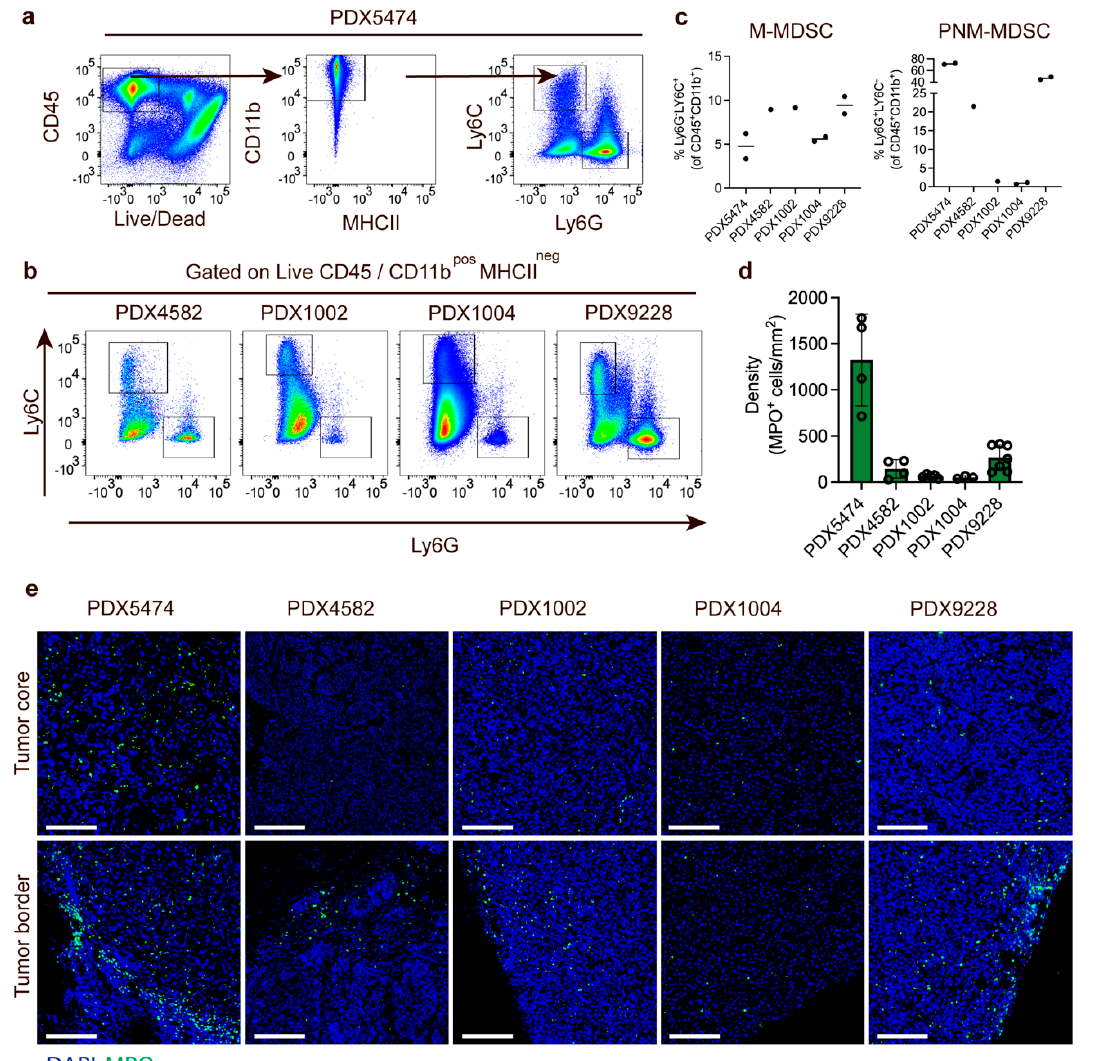
Figure 2. Different levels of MDSC recruitment to breast cancer PDX models. ( a ) Gating strategy for quantification of M-MDSC and PMN-MDSC in PDX tumors using PDX5474 as an example. ( b ) FACS plot showing the distribution of PMN-MDSC (Ly6C − LyG6 + ) and m-MDSC (Ly6C + LyG6 − ) in PDX4582, PDX1002, PDX1004, and PDX9228 tumors. ( c ) Quantification of M-MDSC and PMN-MDSC relative to the CD45 + CD11b + cells in PDX5474 (n = 2), PDX4582 (n = 1), PDX1002 (n =1), PDX1004 (n = 2), and PDX9228 (n = 2) tumors. ( d ) Quantification of MPO-positive cells in immunofluorescence-stained tumor sections from PDX5474 (n = 4), PDX4582 (n = 4), PDX1002 (n = 5), PDX1004 (n = 3), and PDX9228 (n = 7). Data are presented as the number of cells per mm 2 . Four randomly selected areas from each tumor were used for the quantification. ( e ) Representative immunofluorescence staining of the PDX5474, PDX4582, PDX1002, PDX1004, and PDX9228 tumors showing myeloperoxidase-positive cells (MPO, green) and nuclear staining (DAPI, blue). For each tumor, images showing the tumor border and tumor core are presented. Scalebars: 100 µ M. The PDX tumor size and timepoint upon harvest are shown in Supplementary Table